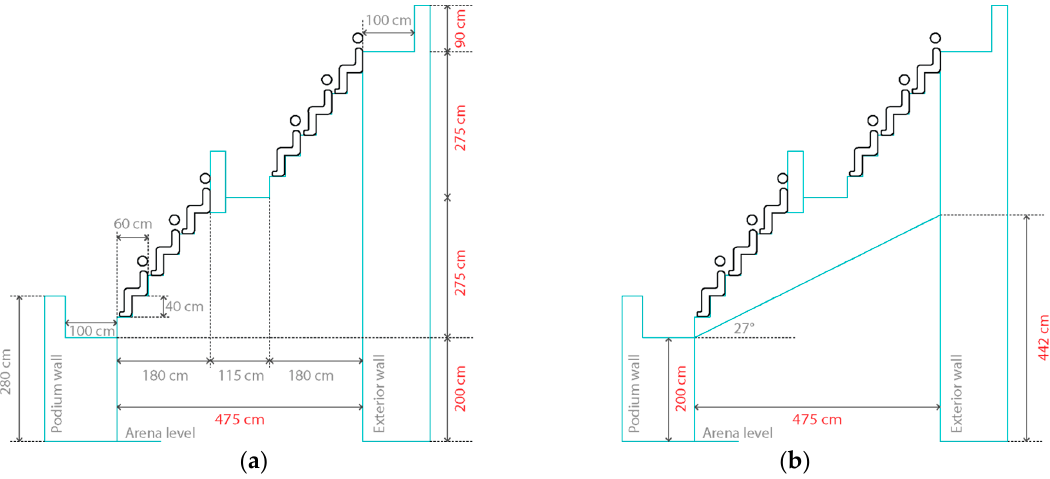
Figure 6. Hypothetical cross-section of the circus showing the distribution of seats, according to the measurements coming out from the laser scanning campaign (in red are the measurements taken on the field): ( a ) subdivision between different social classes ( b ) Hypothetical inclination of the vault.